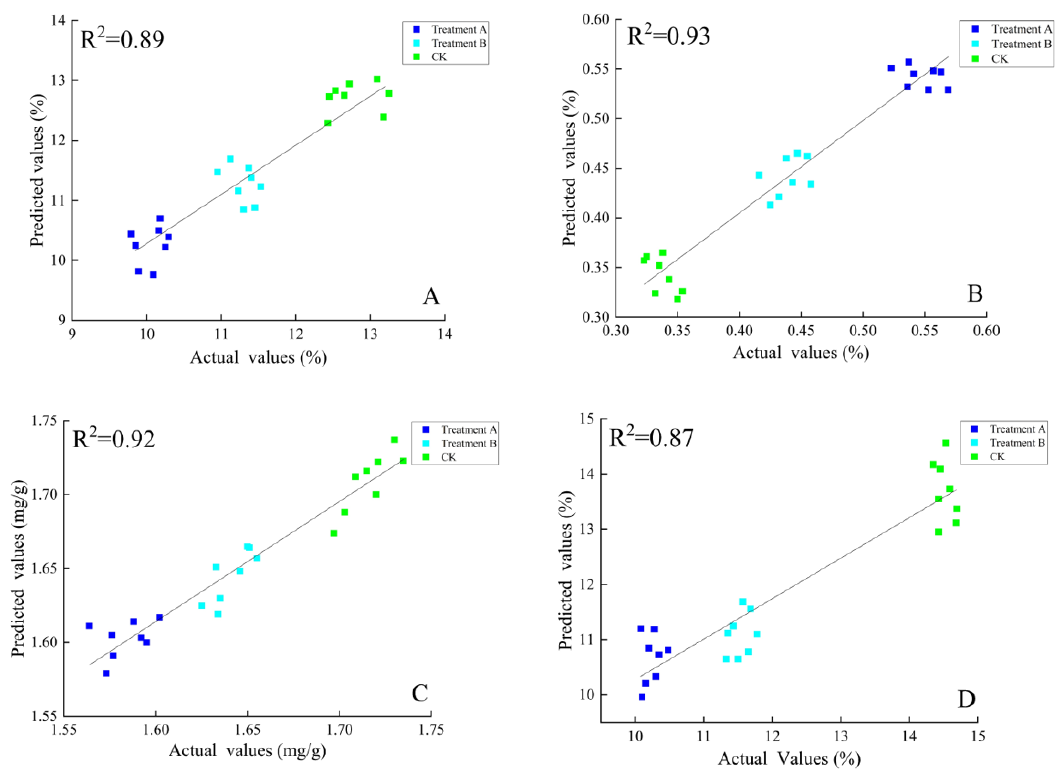
Figure 10. Partial least squares regression (PLSR) results for predicted quality indexes based on the integral value of e-nose response curves. ( A ) Soluble sugar; ( B ) titratable acid; ( C ) soluble protein; ( D ) soluble solids.